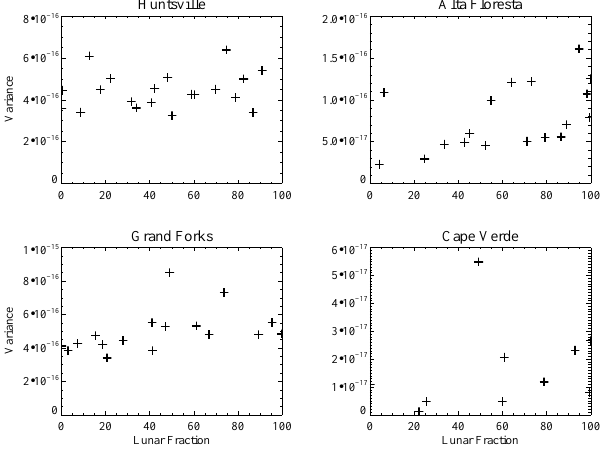
Figure 3. Variance of VIIRS radiance values vs. average lunar frac- tion for each night an τ retrieval was made, separated by